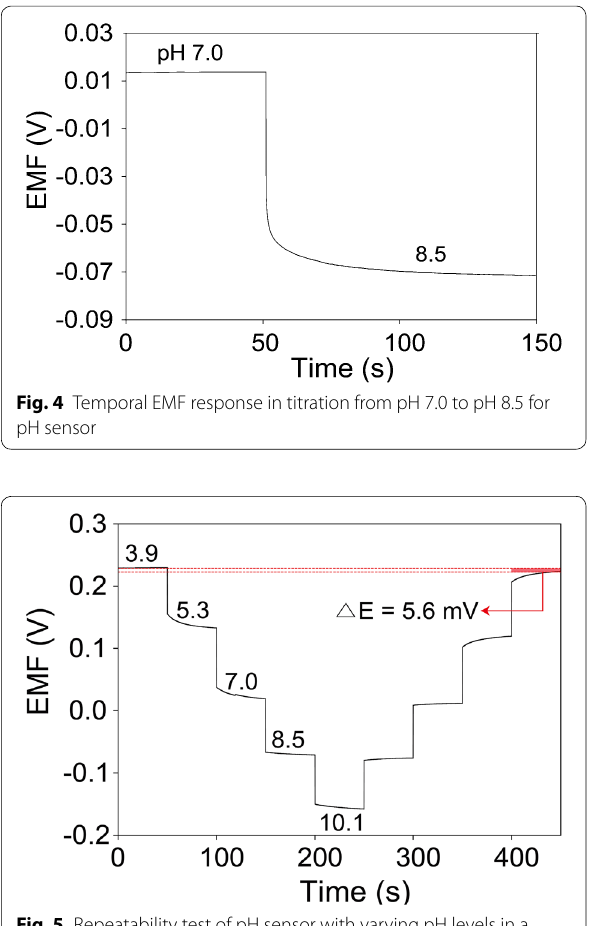
Fig. 5 Repeatability test of pH sensor with varying pH levels in a range of 3.9 ‒ 10.1